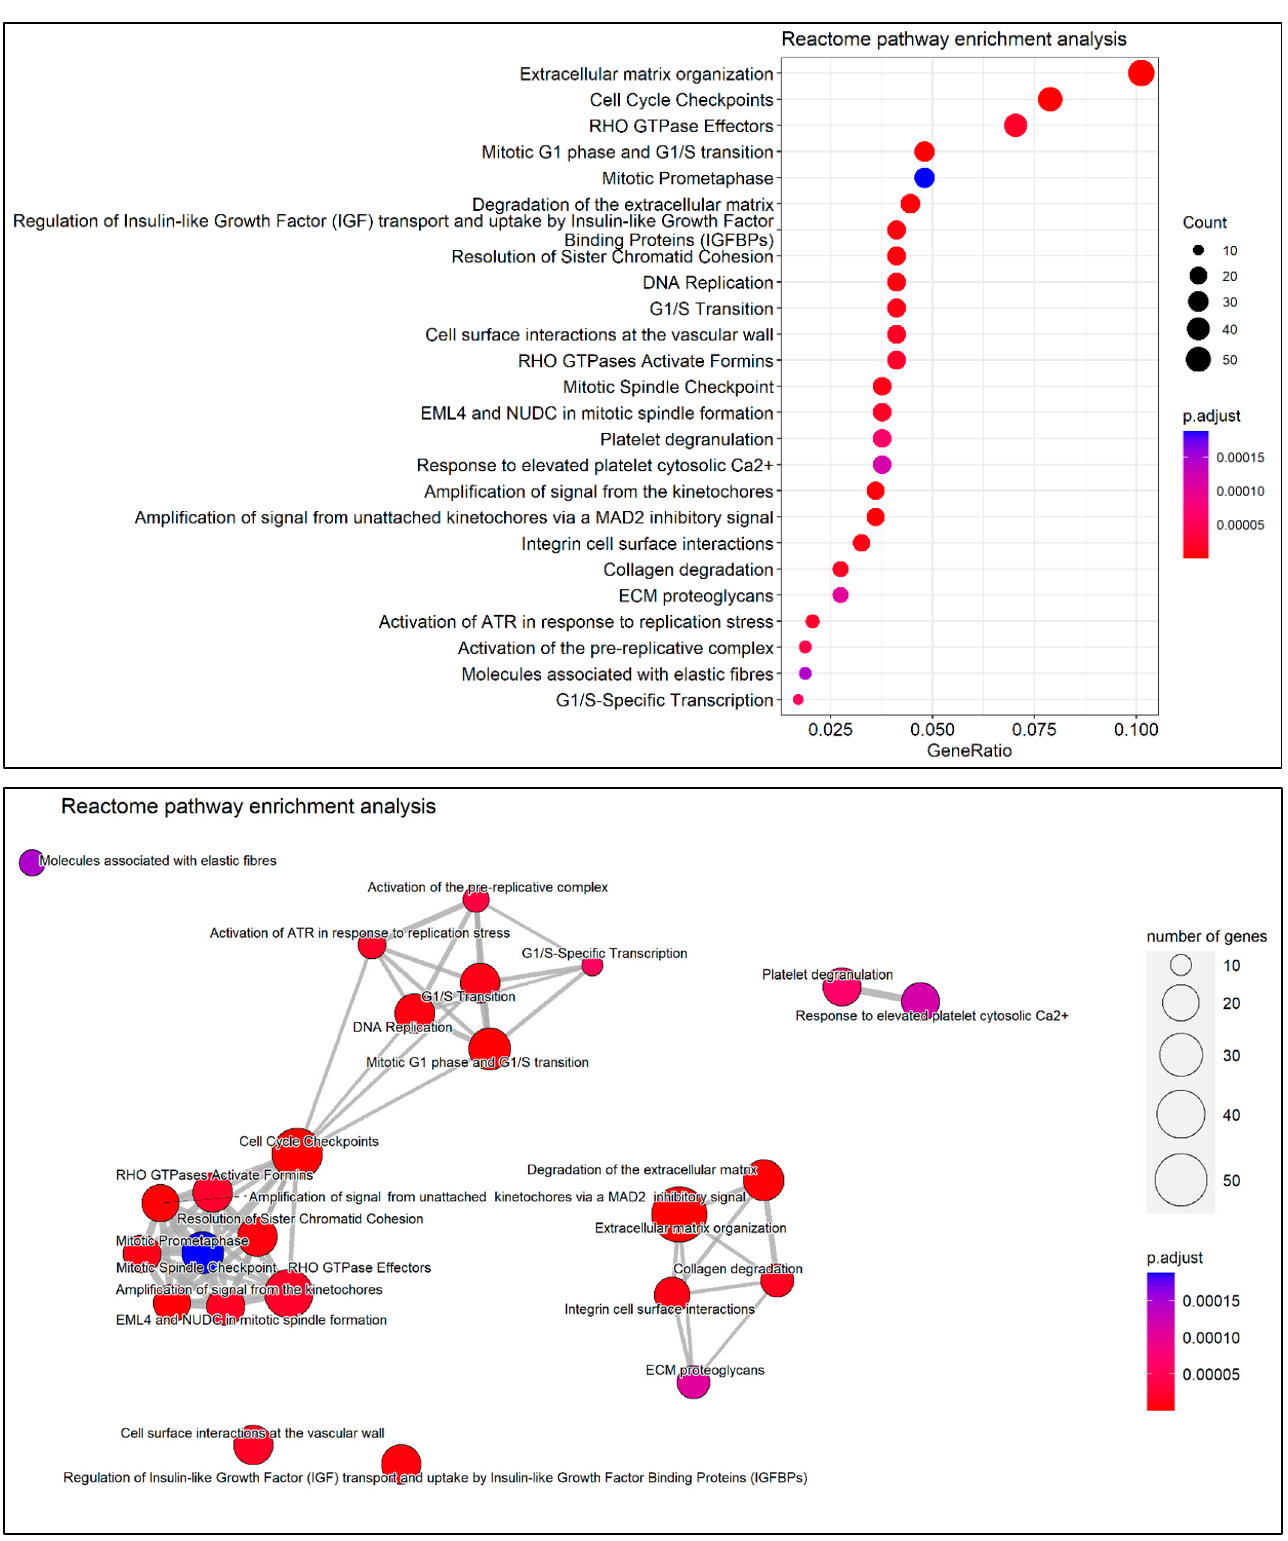
Figure 6. ( Upper ) Top 25 significant terms of the Reactome pathway enrichment analysis. ( Lower ) Enrichment map of the Reactome enriched terms presented into a network.